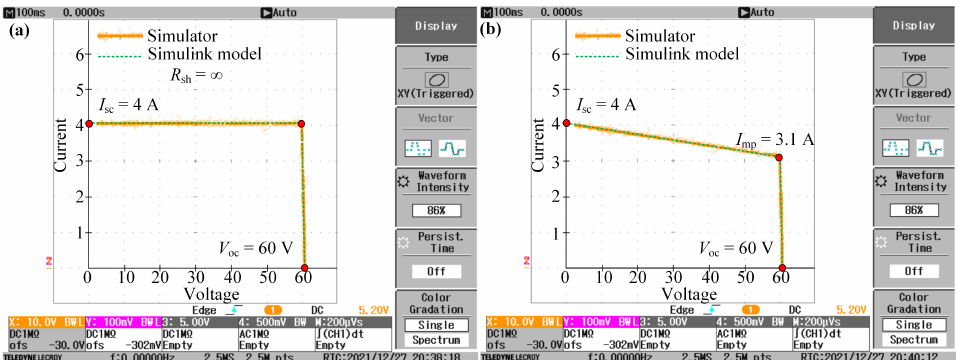
Figure 15. Experimental I-V curves obtained on the simulator and its MATLAB Simulink model for shunt resistances ( a ) R sh = ∞ ; ( b ) R sh = 66.67 Ω